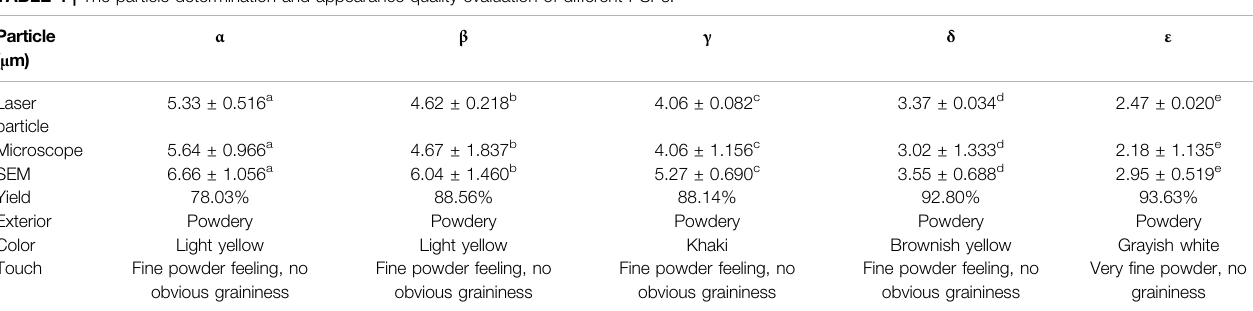
TABLE 4 | The particle determination and appearance quality evaluation of different